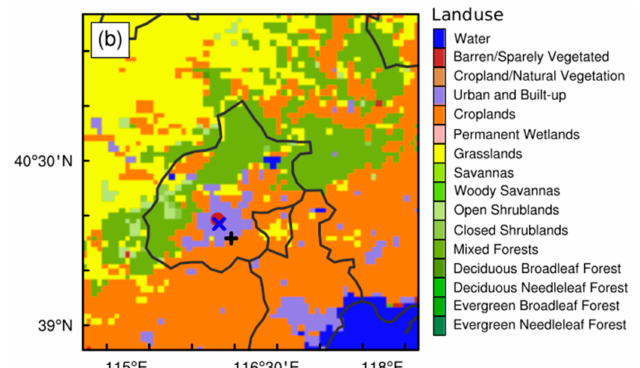
Figure 1. Maps of ( a ) Weather Research and Forecasting model coupled with chemistry (WRF-Chem) simulation domain and anthropogenic NH 3 emissions in May, 2016, and ( b ) the land use types in Beijing and its adjacent regions. The location of Beijing is denoted by the red lines in Figure 1a, and the locations of the NH 3 monitoring site, PM 2.5 monitoring site, and meteorological site in Beijing are marked by the blue cross, red dot, and black plus in Figure 1b, respectively. The dashed rectangle in Figure 1a indicates the regions using the emission zero-out method in the WRF-Chem